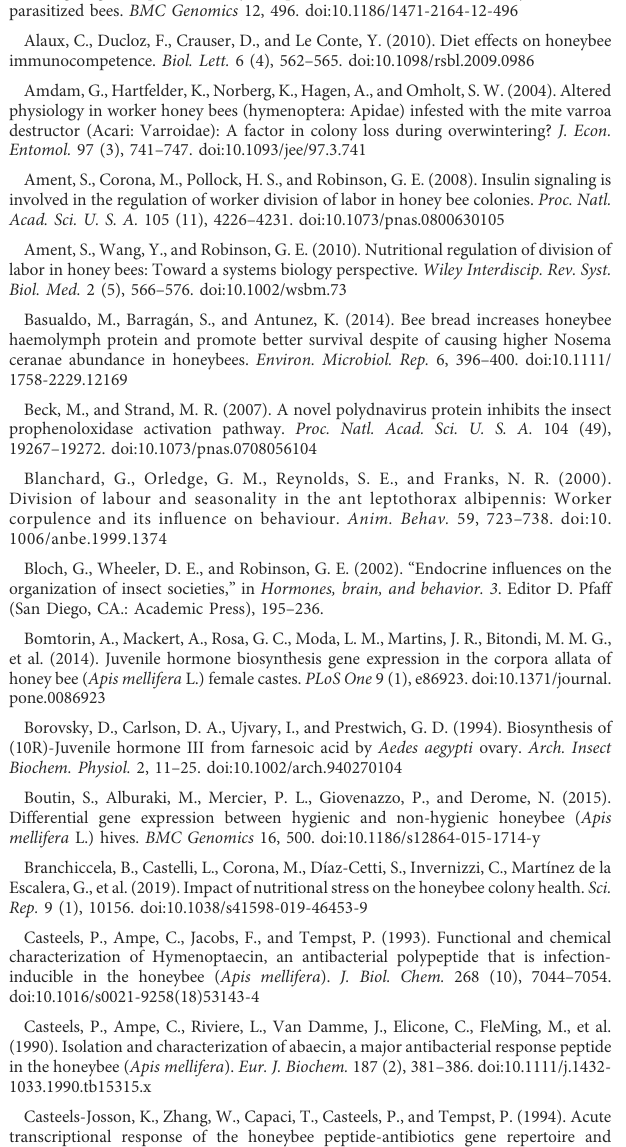
SUPPLEMENTARY TABLE 2 Effects of behavior, nutrition and age on gene expression and viral titers. Differencesbetweengroupsofvariablesful fi llingtheassumptionsofparametric statistics were analyzed with ANOVA. Non-parametric variables were analyzed by Mann Whitney test. Signi fi cant p - values are indicated in red case. SUPPLEMENTARY TABLE 3 Average relative values (ARVs) of ampli fi ed targets (genes and viruses). Values ARVs were calculated relative to the housekeeping gene Rps5 , taking in consideration all the behavioral/nutritional/age groups (Total) or each of thedifferentcombinationofvariables. Abbreviations:Nurses (N) Foragers (F);